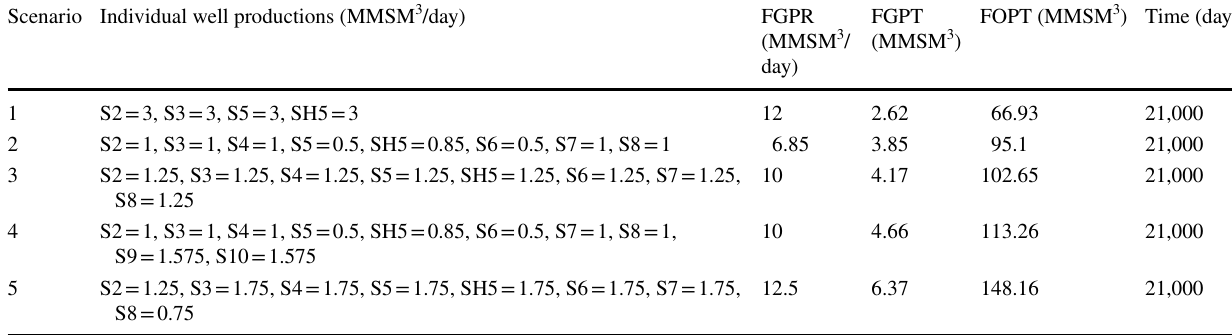
Table 5 Summary implementation scenarios for reservoir natural depletion Scenario Individual well productions (MMSM 3